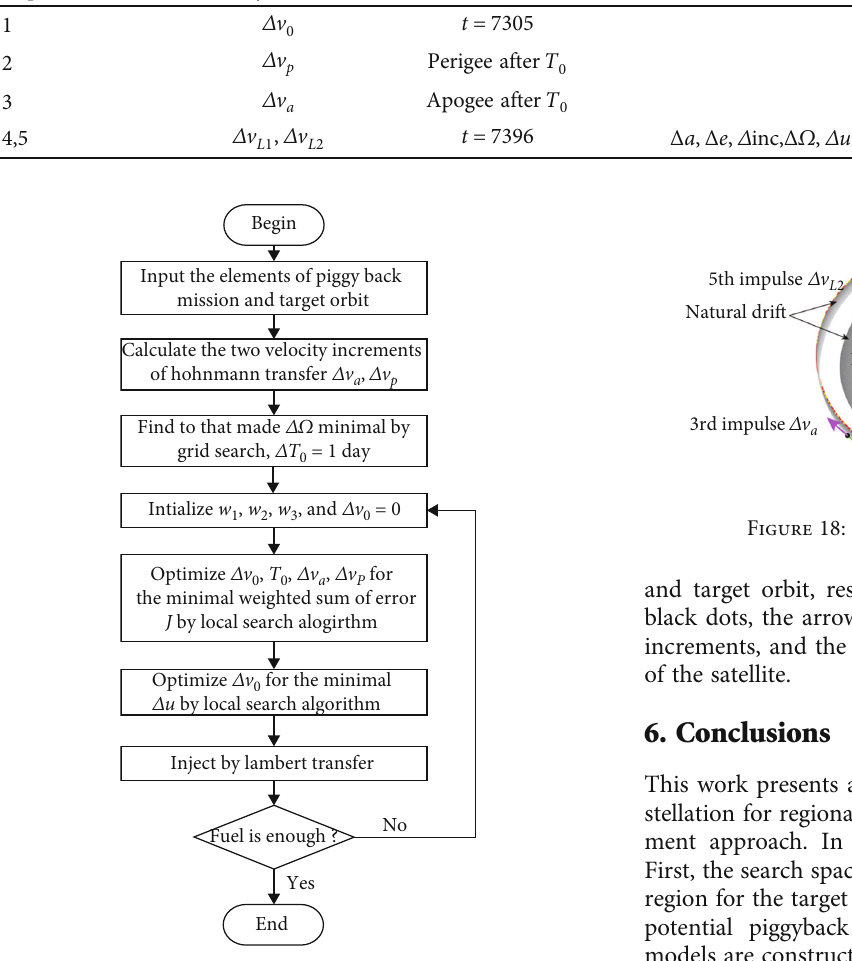
Figure 17: Flowchart of the transfer design process. Table 8: Transfer procedure of satellite #15.